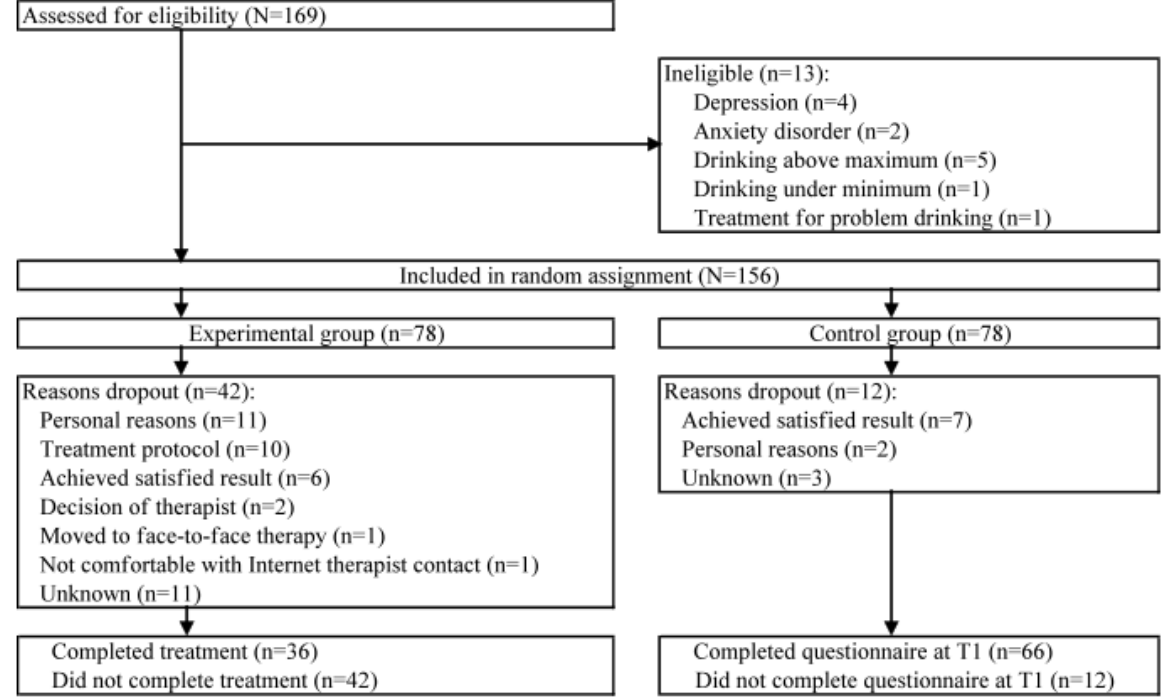
Figure 1. CONSORT diagram: flow of participants through the study